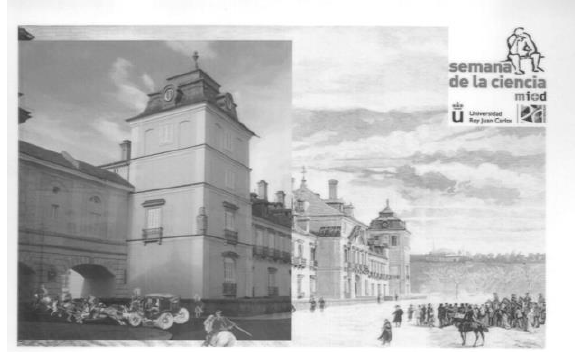
Figure 6. AR Drawings. El